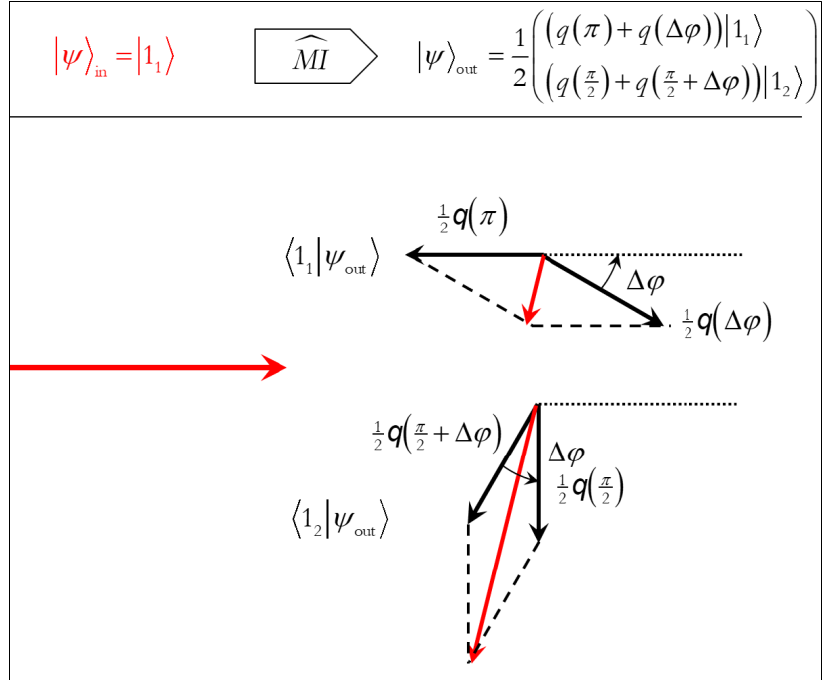
Figure A6. Pointer representation of single photon interference from a Michelson interferometer the transformation | ψ in → | ψ out is mediated by the matrix Mi . We assume the interferometer is adjusted so that the state evolution between beam splitter and the mirrors leads to × d / c =2π (see Equation (A2)). The displacement of mir- ror 1 adds a phase Δ , thus 4 = 2π + Δ : This results expectedly gives the quantum interference pattern from Figure 3b. Quan- tum interference means, interference without waves. The experiment demonstrates trans- parent experimental evidence of the phase sensitivity of the probability amplitudes. The total probability, summed over the output modes equals one, as it should be. The pointer representation of Equation (A9) (Figure A6) illustrates this result: Adding the pointers gives the total quantum state, calculating the square of the pointer length gives the prob- ability.